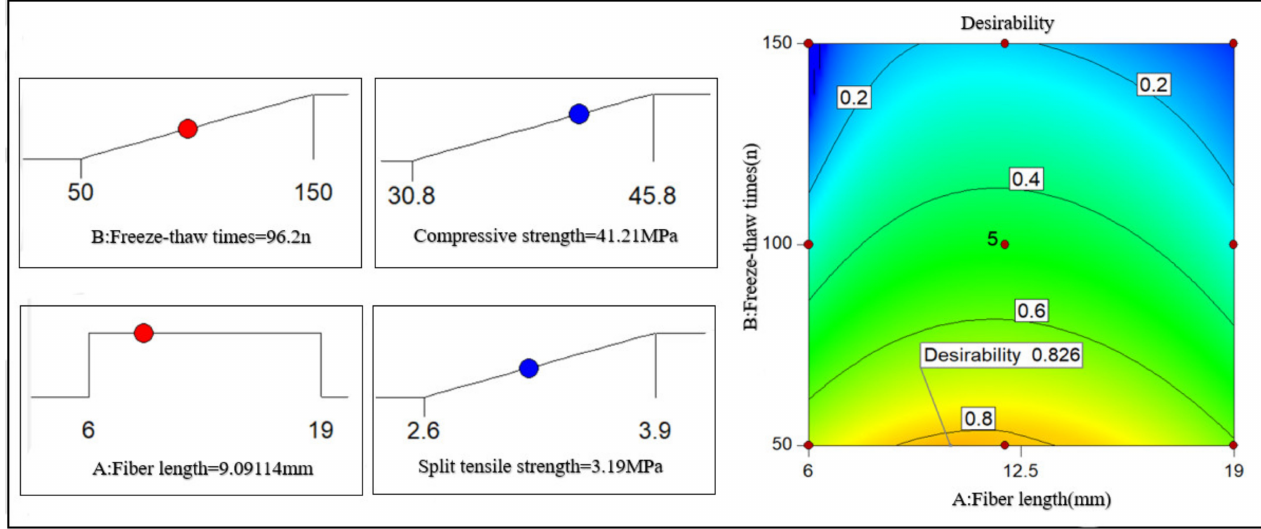
Figure 11. PFMSC and Optimization results of strength maximization